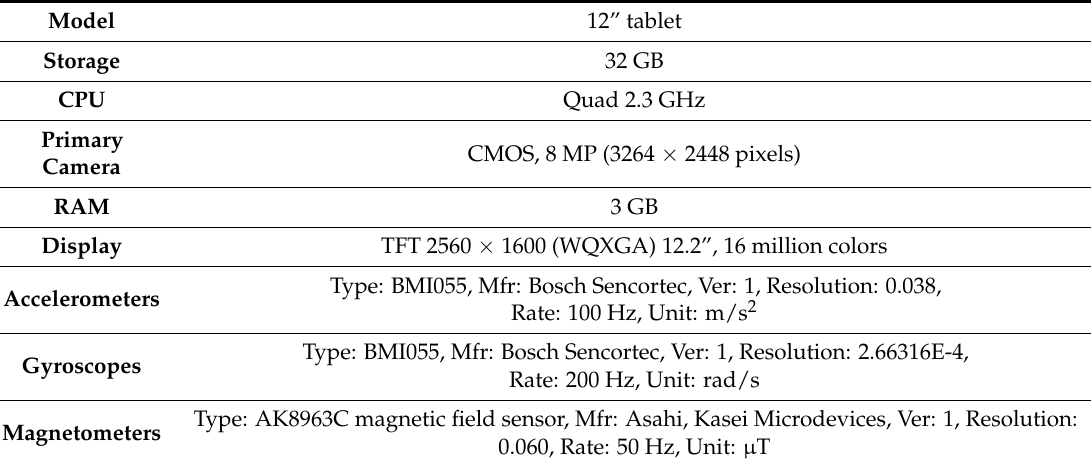
Table 1. Technical specifications of the mobile device used in the augmented reality (AR) application. CPU, central processing unit; RAM, random access memory; CMOS, complementary metal-oxide